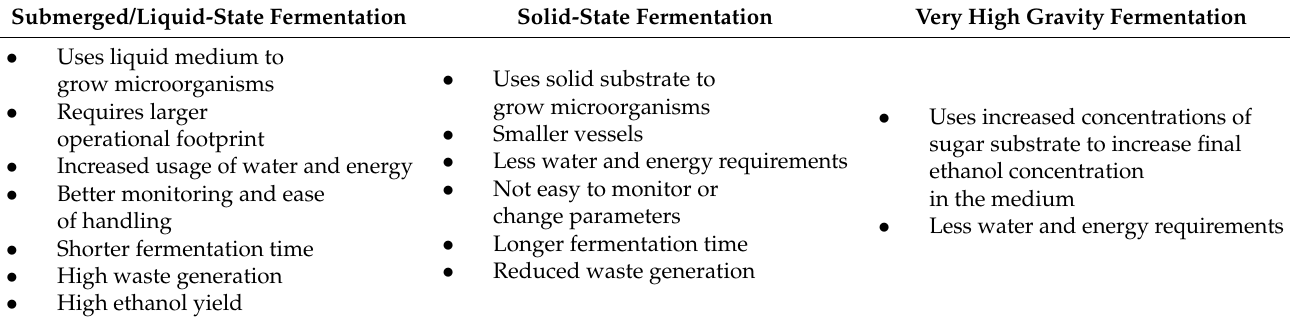
Table 2. Comparison of three fermentation